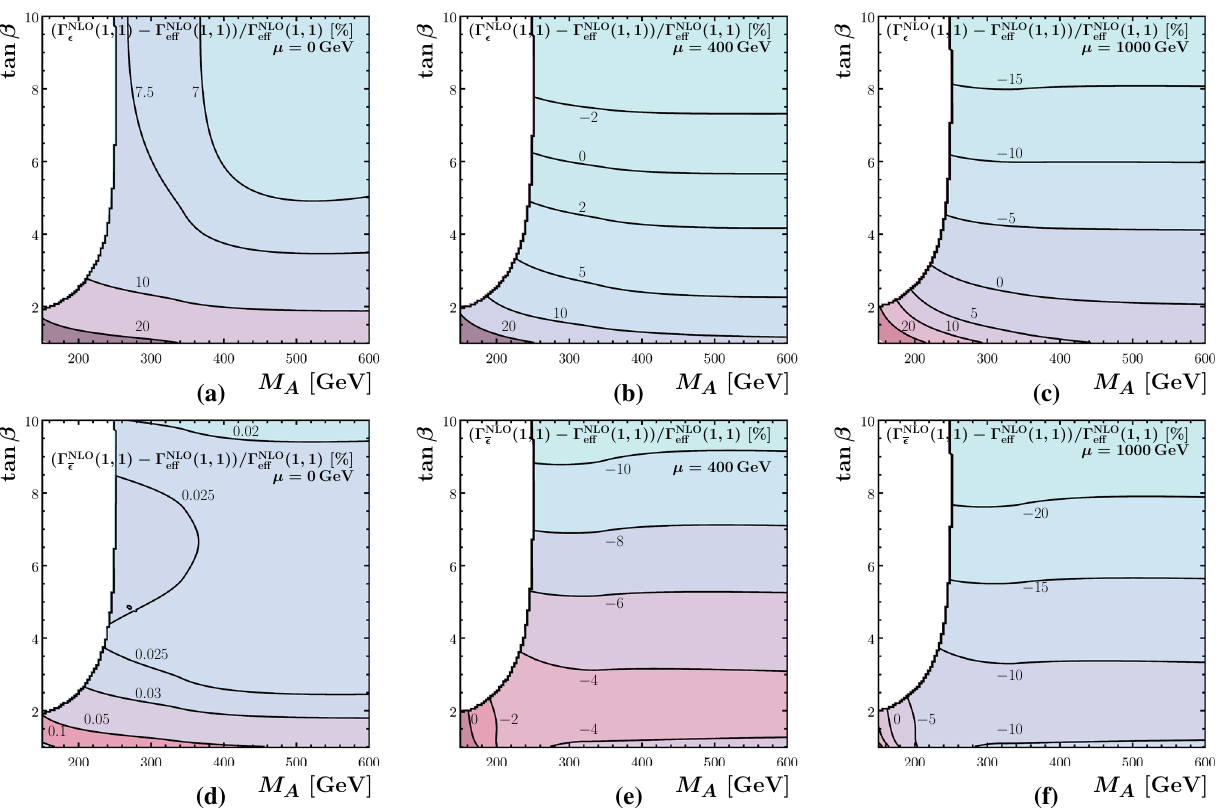
( 1 , 1 ) including λ eff Hhh eff